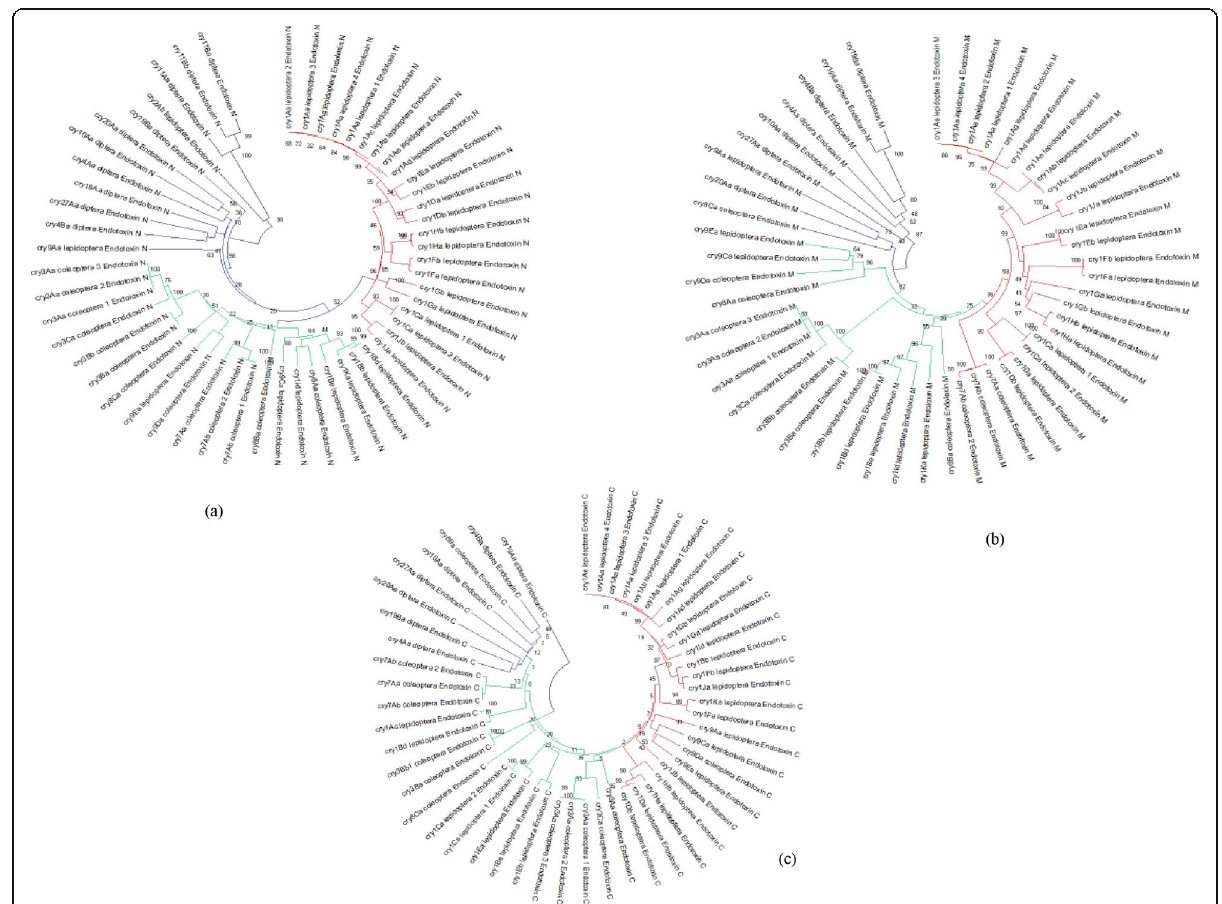
Fig. 4 a Phylogenetic tree of Cry protein domains for Coleoptera using MEGA X. b Phylogenetic tree of Cry protein domains for Diptera using MEGA X. c Phylogenetic tree of Cry protein domains for Lepidoptera using MEGA